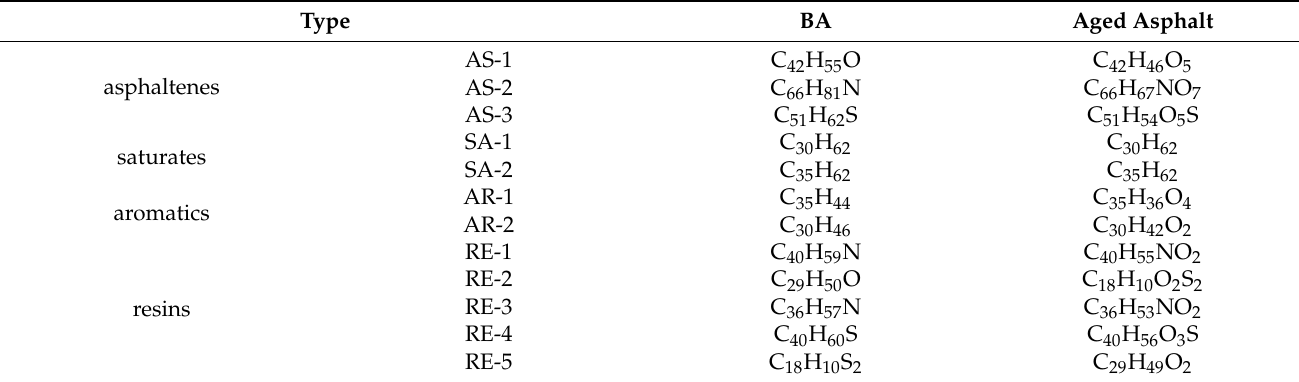
Table 3. Molecular composition of